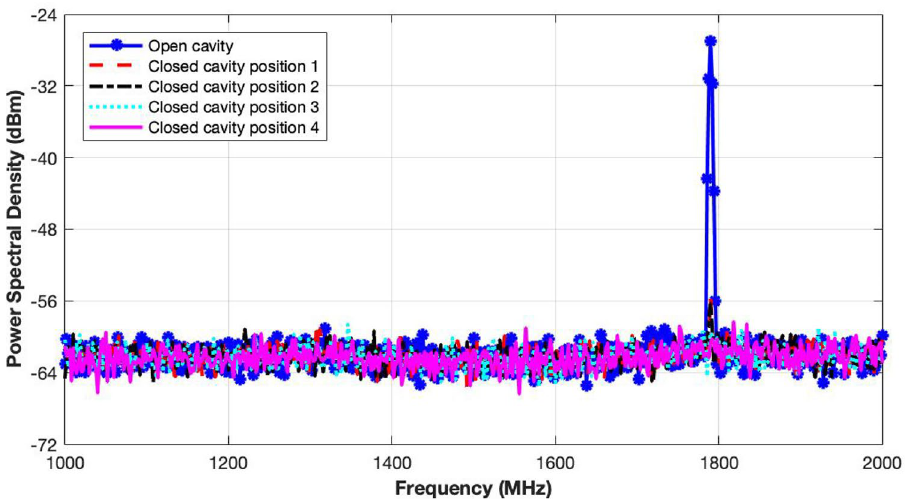
Figure 12. Power leakage test measurements of the gold-plated exposure system through observation of power spectral densities at different points on the